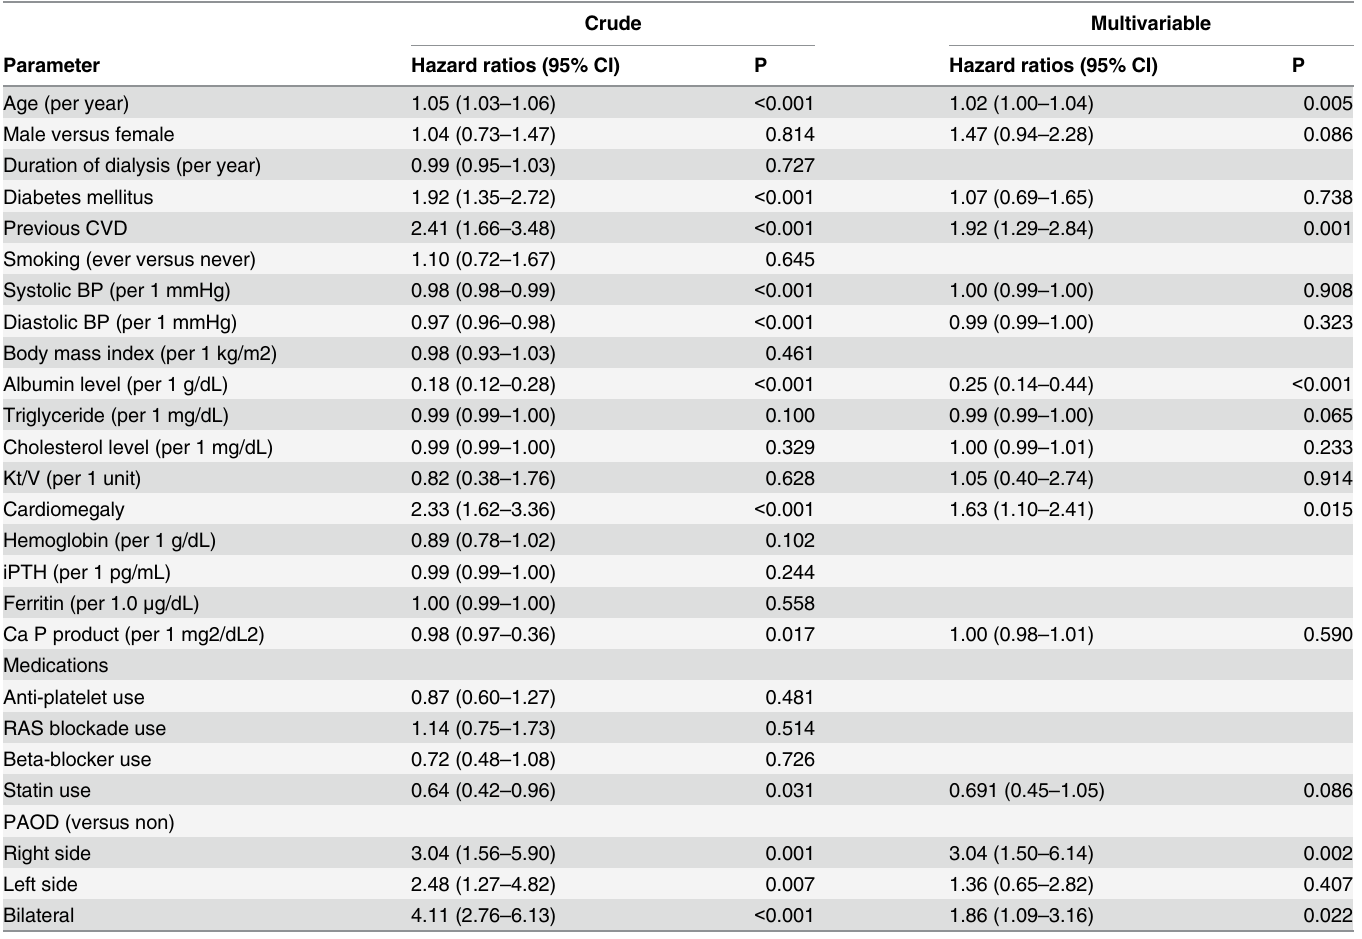
Table 3. Cox proportional hazards regression analysis for all-cause mortality. Crude